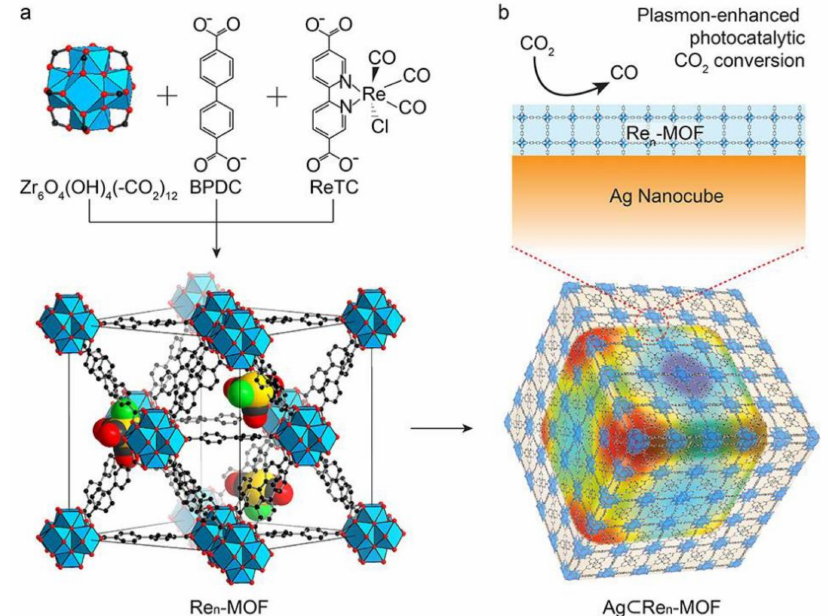
Figure 6. Structures of Re n -MOF and Ag ⊂ Ren-MOF for plasmon-enhanced photocatalytic CO 2 conversion. ( a ) Zr 6 O 4 (OH) 4 ( − CO 2 ) 12 secondary building units are combined with 4,4 (cid:48) - biphenyldicarboxylate (BPDC) and ReTC linkers to form Re n -MOF. The structure of Re 3 -MOF is shown, as identified from single-crystal X-ray diffraction. The 12 coordinated Zr-based metal clusters are interconnected with 21 BPDC and 3 ReTC linkers in a face-centred cubic array. Atom labeling scheme: C, black; O, red; Zr, blue polyhedral; Re, yellow; Cl, green; H atoms are omitted for clarity. ( b ) Ren-MOF coated on an Ag nanocube for enhanced photocatalytic conversion of CO 2 . Reprinted with permission from [102]. Copyright 2017, American Chemical